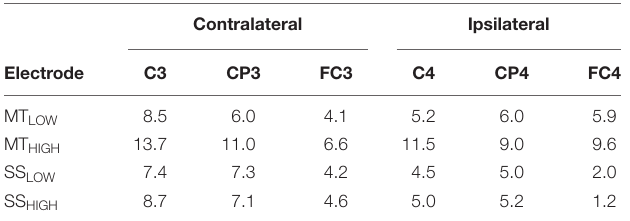
TABLE 1 | Decrease in alpha power in sensorimotor electrodes given as relative change (%) from baseline